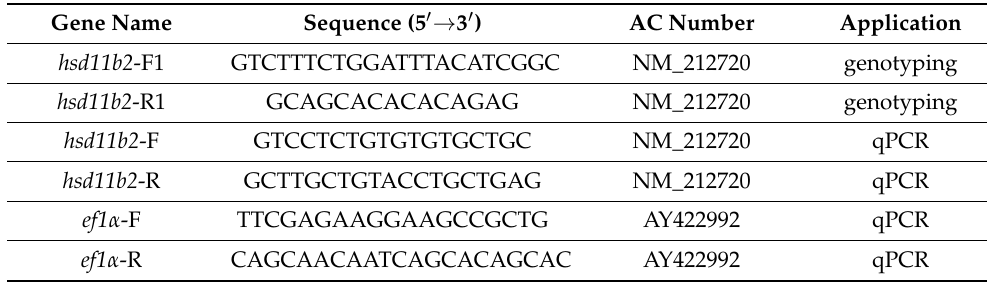
Table 1. List of primers used in the corresponding